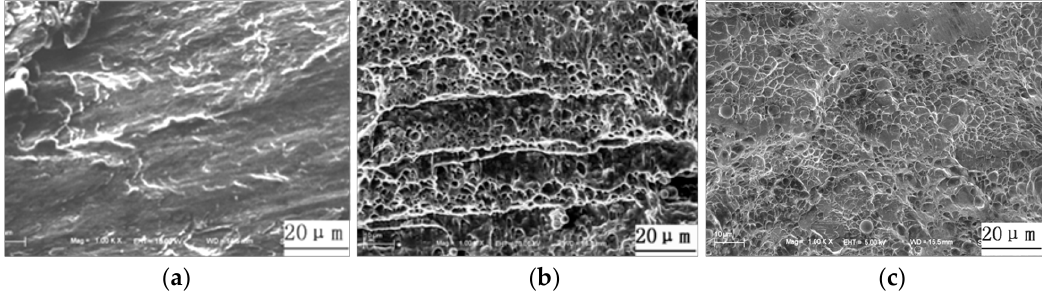
Figure 15. SEM images of the fracture surface: ( a ) Interface failure; ( b ) pullout failure (base metal tear fracture); ( c ) pullout failure (pullout tear fracture).